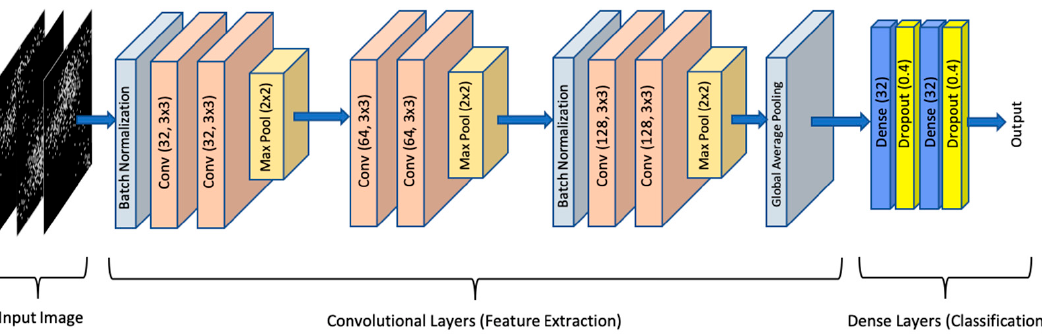
Figure 3. CNN architecture used in this study. There are six convolutional layers of which the first two have 32 filters, the third and fourth have 64 filters and the last two layers have 128 filters with 3 × 3 paramethers.